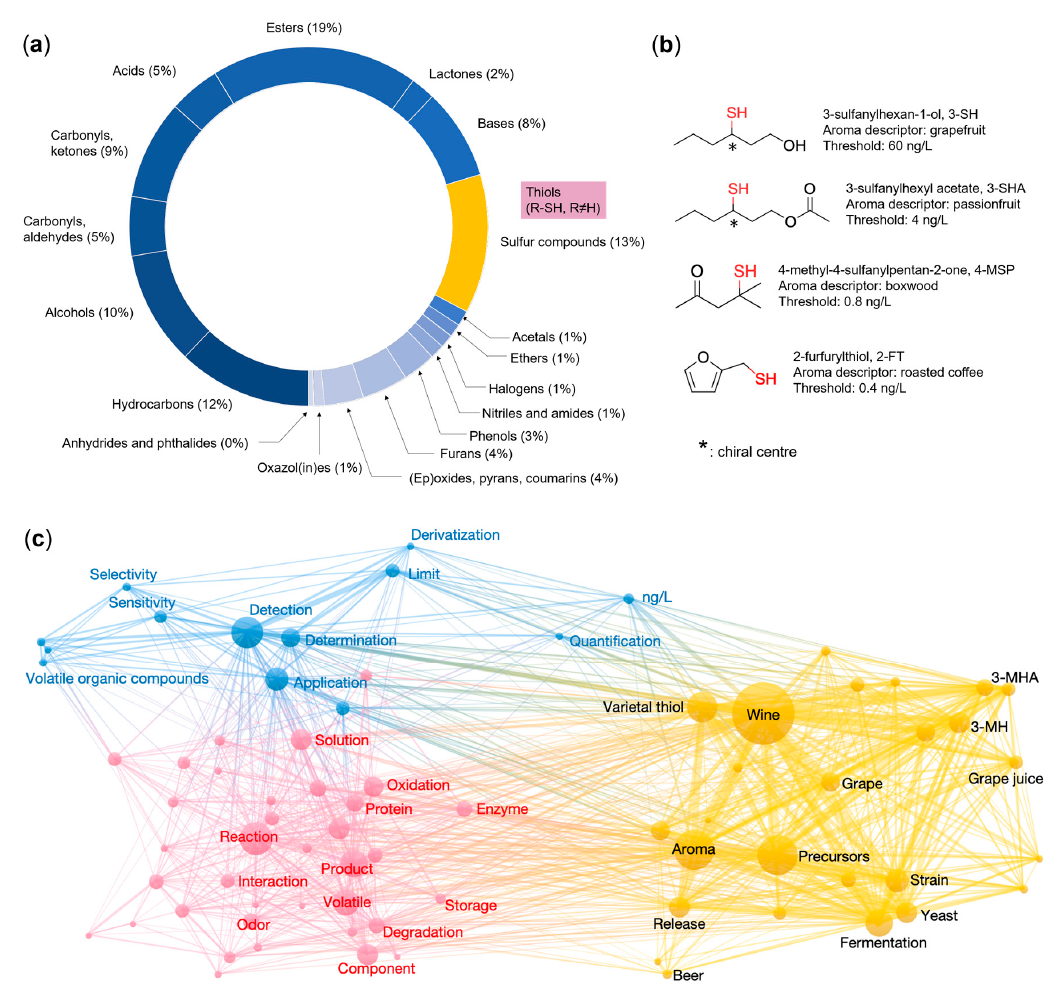
Figure 1. ( a ) Doughnut chart showing the relative percentages of volatile sulfur compounds